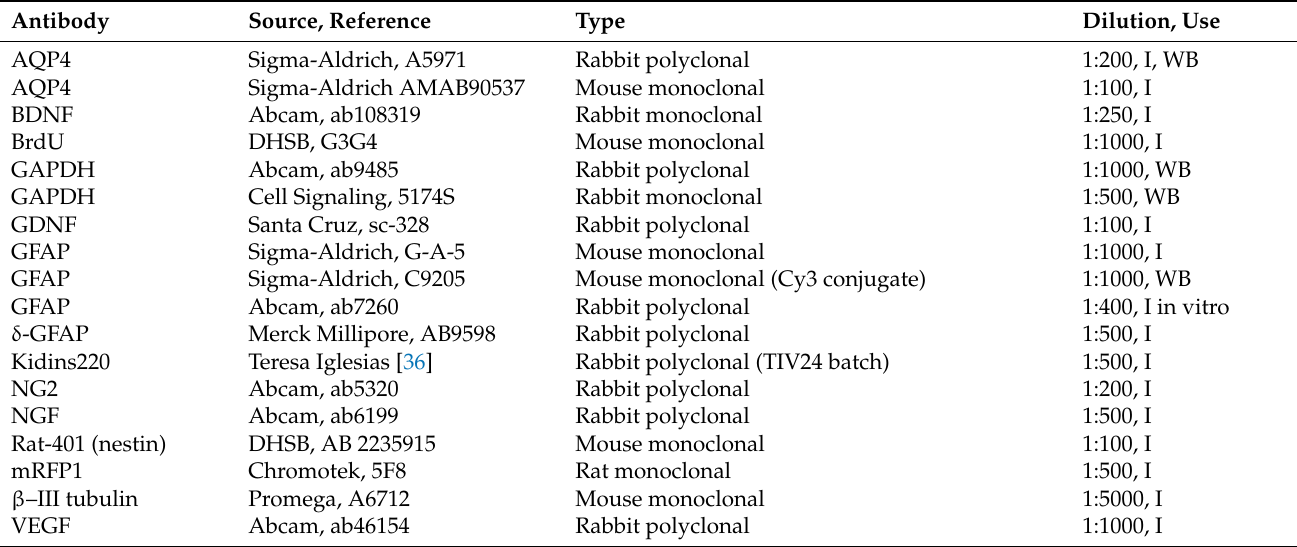
Table 3. Primary antibodies used for immunolabeling. Chromotek; Planegg-Martinsried, Germany. DSHB; Developmental Studies Hybridoma Bank, Iowa City, IA, USA. Promega; Madison, WI, USA. Abbreviations: I, immunofluorescence or immunohistochemistry; WB, Western